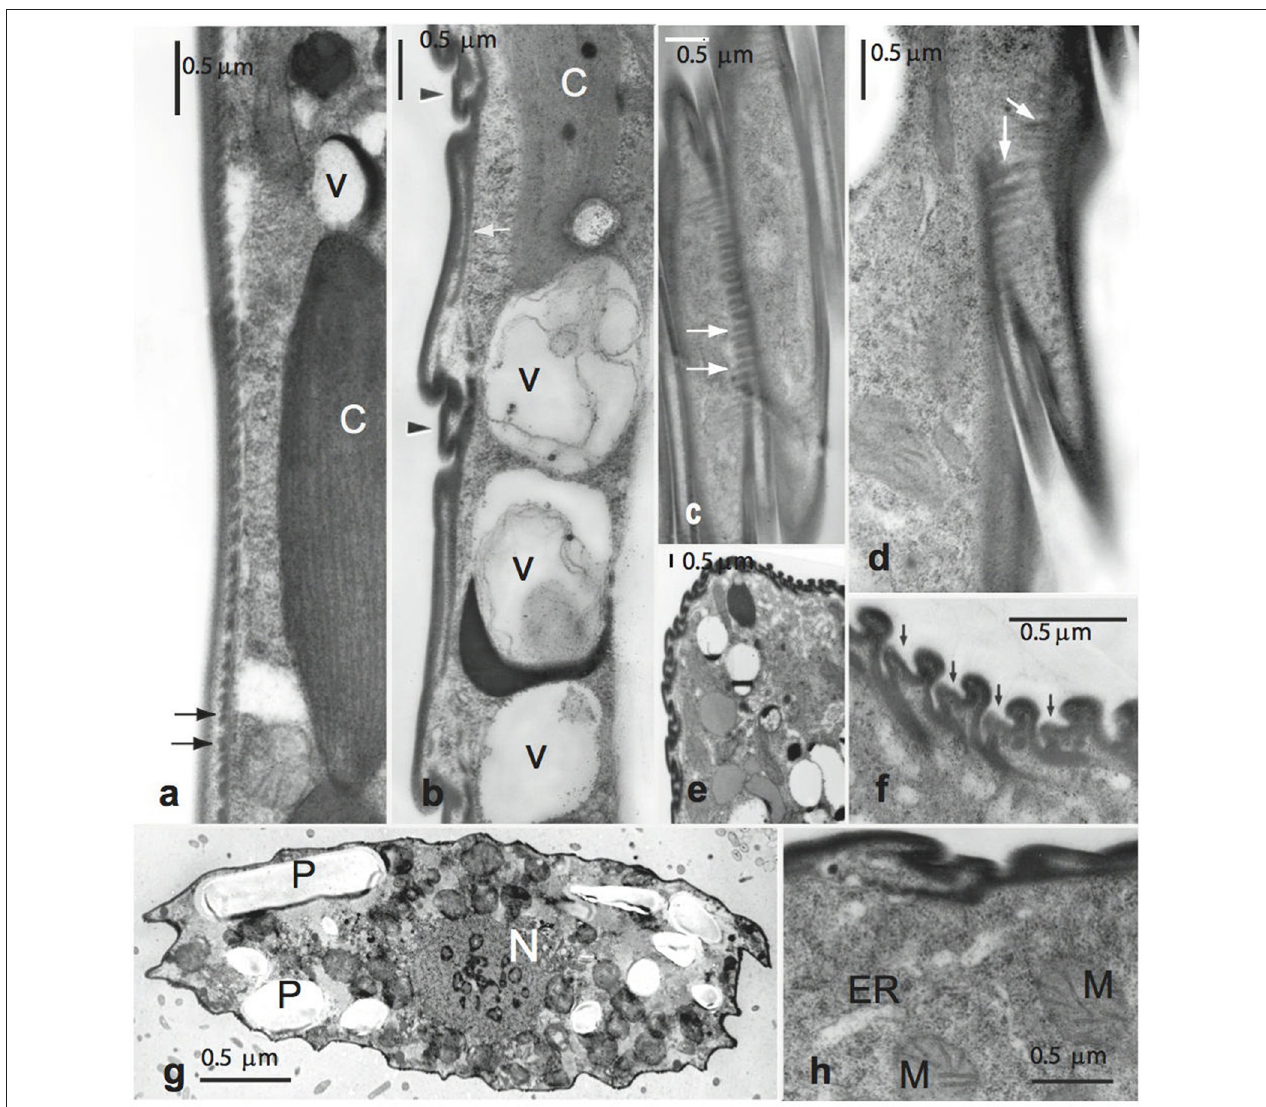
FIGURE 2 | Transmission electron micrographs of Lepocinclis acus. (a) Control cell showing a continuous contour and the tooth-like projections in transverse section (arrows) Normal chloroplast (C). (b–h) Treated cells. (b) New strips between the old ones (arrowheads) and vacuoles (V) containing electron dense material and membranes were observed. (c,d) Tangential sections showing the periodicity and thickness of the tooth-like projections (arrows). (e) Anterior end of a cell showing clearly the new formed strips. (f) Detail of figure (e) , arrows indicate the new strips. (g) Transversal section showing mitochondrial profiles (M), the nucleus (N) and paramylon grains (P). (h) Detail of the mitochondrial profiles (M) and endoplasmic reticulum (ER) distributed near to the